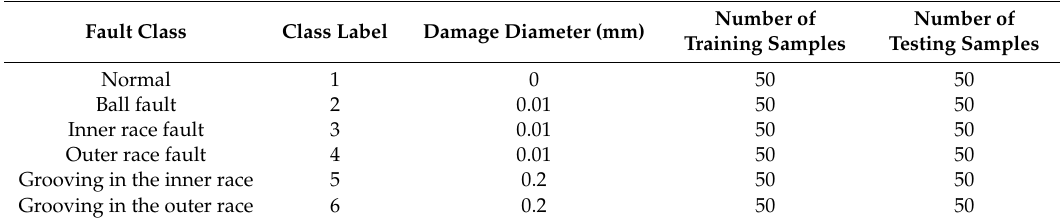
Figure 13. Confusion matrix using the proposed HLZC method for Experiment 1.